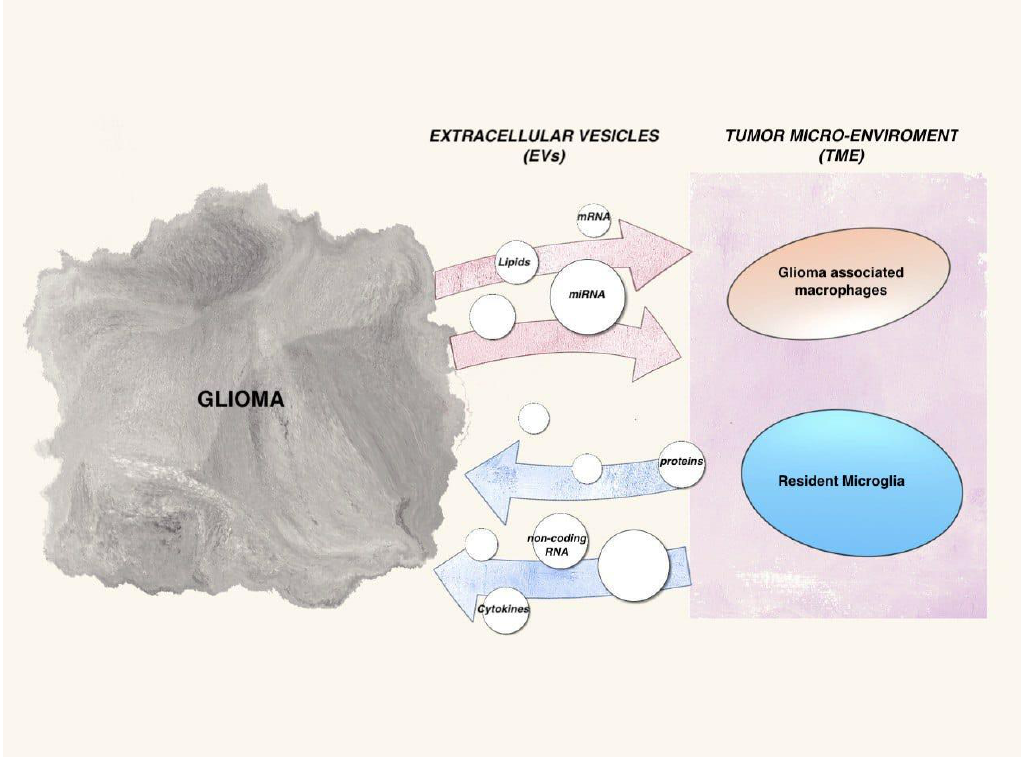
Figure 3. Schematic representation of glioma-TME communication through EVs.